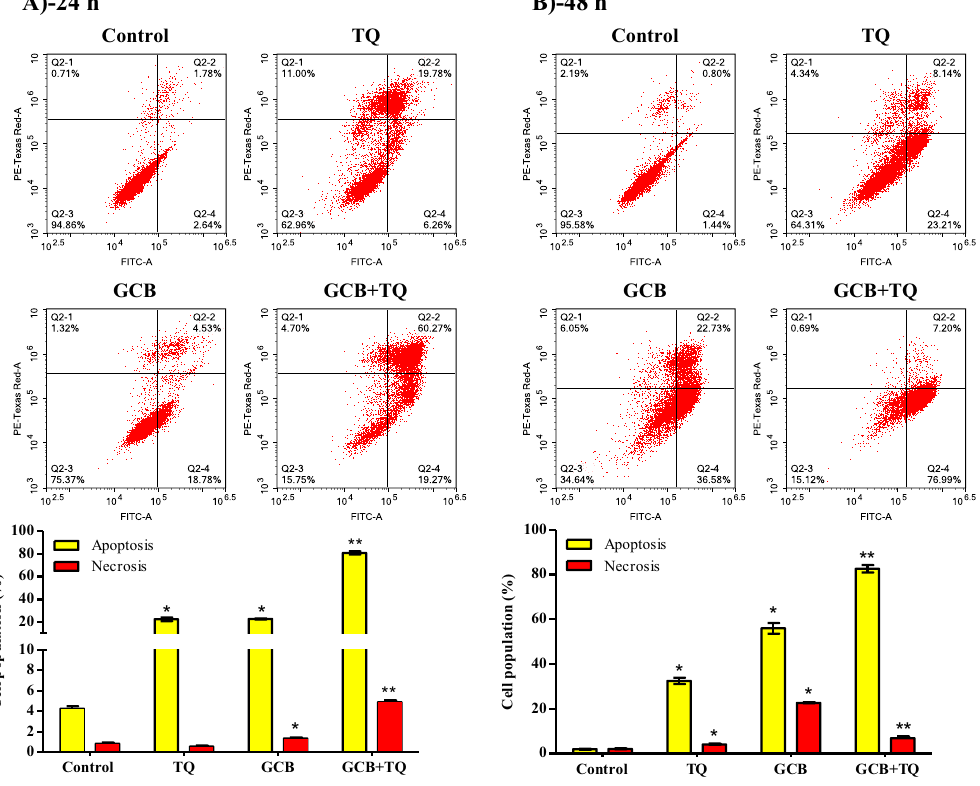
Figure 4. Apoptosis/necrosis assessment in T47D cells after exposure to GCB, TQ and their combination. Cells were exposed to GCB, TQ or their combination for 24 h ( A ) and 48 h ( B ). Cells were stained with annexin V-FITC/PI and different cell populations were plotted as percentage of total events. Data is presented as mean ± SD; n = 3. * Significantly different from control group. ** Significantly different from GCB